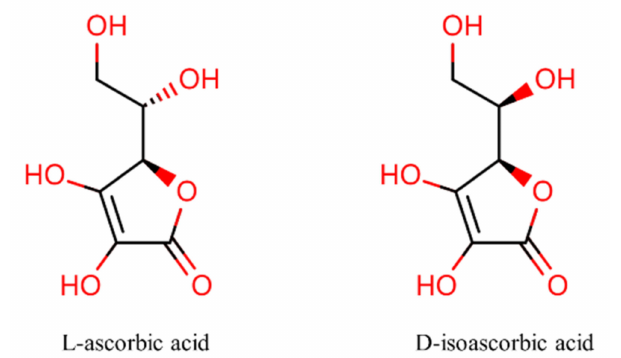
Figure 1. Structures of L-ascorbic acid and its stereoisomer.